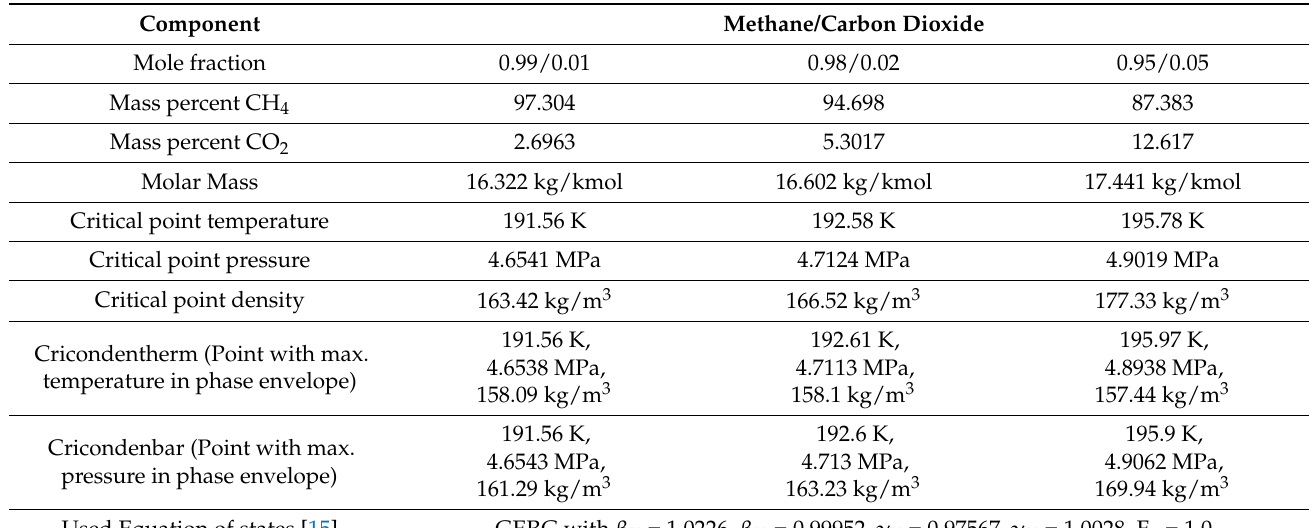
Table 3. Calculated characteristic points of liquid–vapor phase envelopes of some mixtures of methane and carbon dioxide